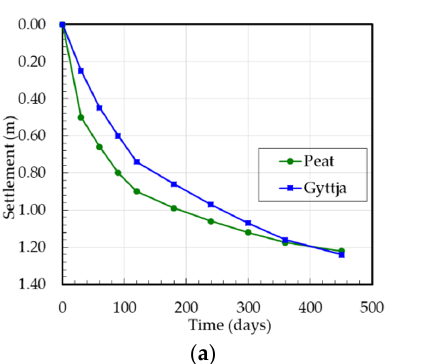
Figure 8. Test embankment at the Wonie ść site: ( a ) settlement versus time, ( b ) undrained shear strength versus time.